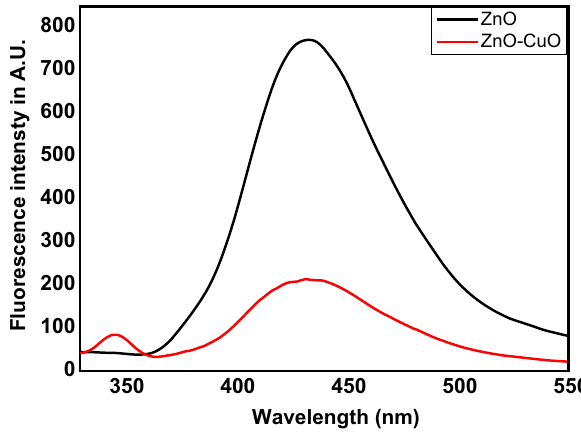
Fig. 2 Fluorescence spectra of aqueous dispersions of ZnO ( black line ) and ZnO–CuO NMs ( red line